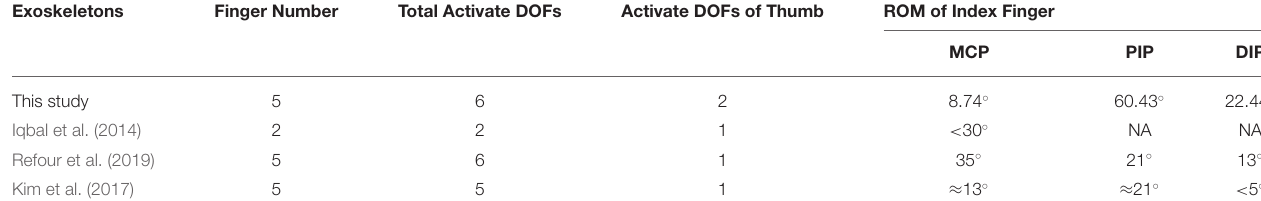
TABLE 1 | Comparison between the new exoskeleton and some previous results. Exoskeletons